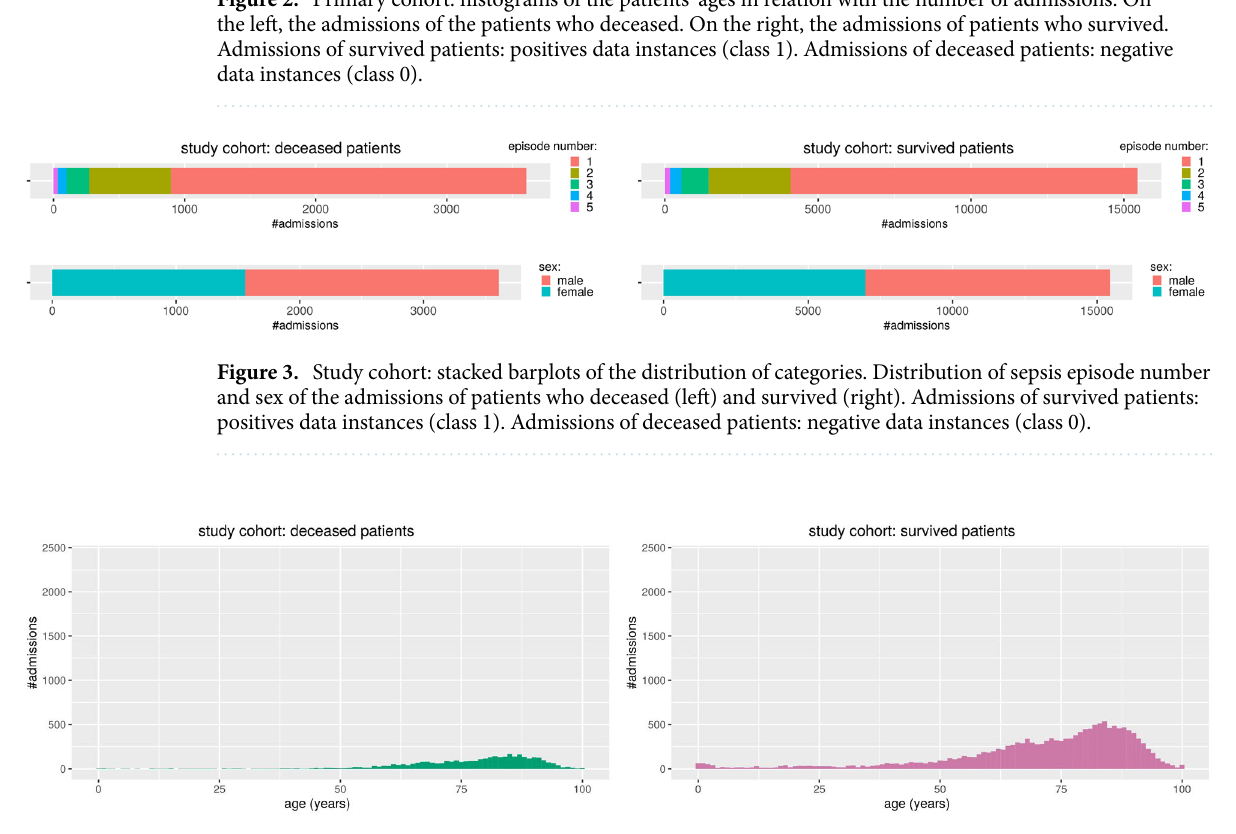
Figure 4. Study cohort: histograms of the patients’ ages in relation with the number of admissions. On the left, the admissions of the patients who deceased. On the right, the admissions of patients who survived. Admissions of survived patients: positives data instances (class 1). Admissions of deceased patients: negative data instances (class